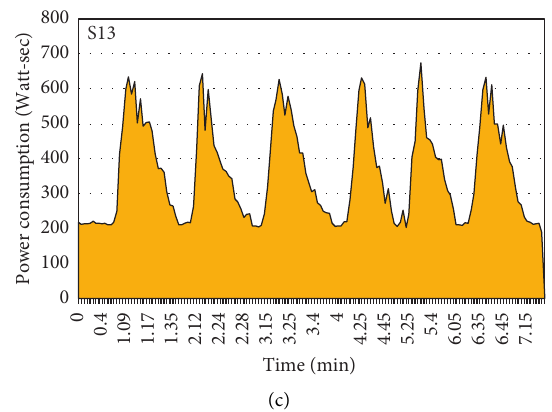
Figure 14: Power consumption curve for M25 grade concrete.